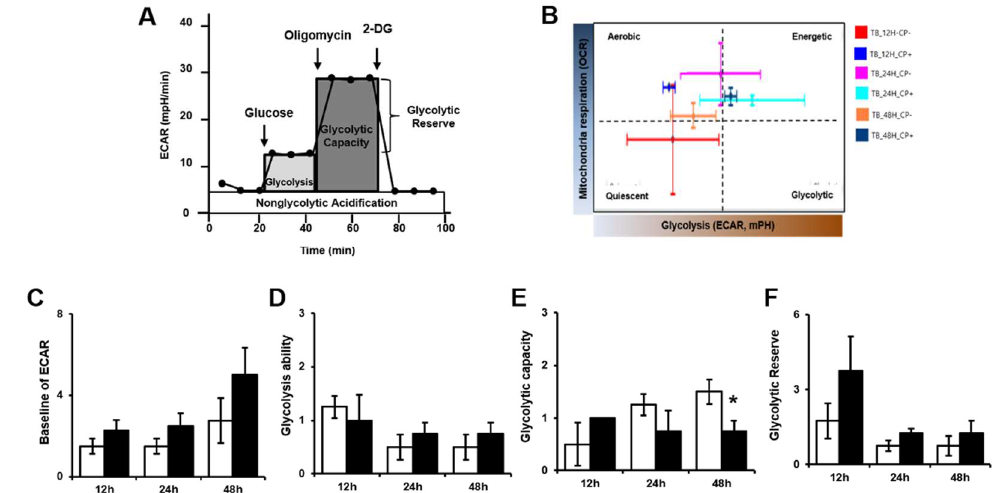
Figure 3. PD-MSCs regulate the glycolytic ability of invasive trophoblasts. ( A ) Schematic illustration of the ECAR. ( B ) The phenotypes of invasive trophoblasts with and without PD-MSC cocultivation over time. ( C ) The baseline ECAR, ( D ) glycolytic ability, ( E ) glycolytic capacity and ( F )